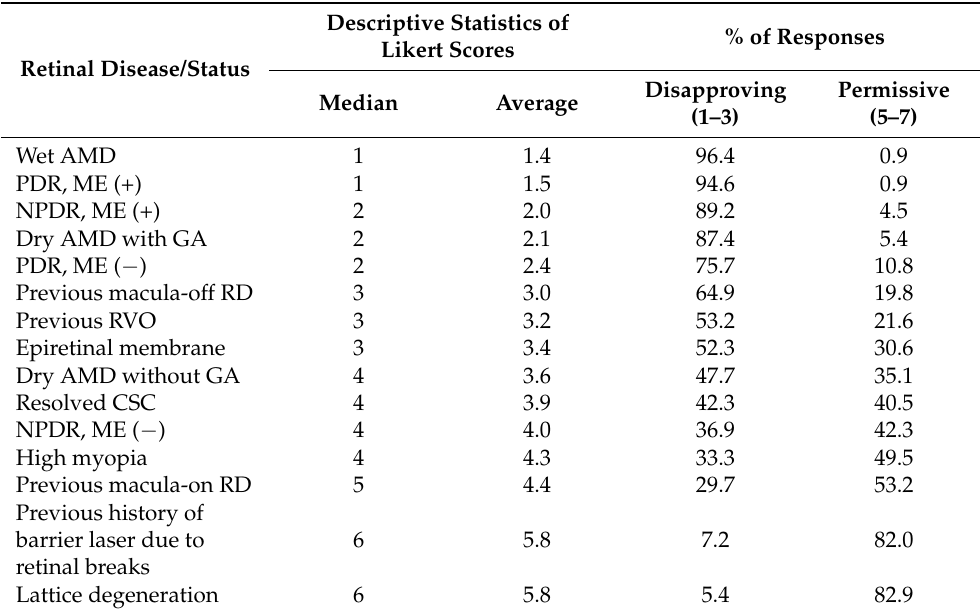
Table 2. The degree of approval of the Korean retinal specialists regarding implantation of diffractive multifocal intraocular lenses in eyes with each of retinal